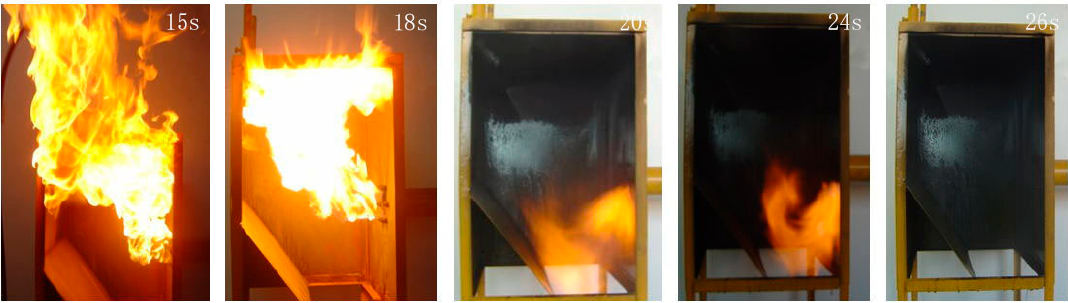
Figure 11. Experimental schematic diagram of the drilling hole gas fire suppressed by water mist.